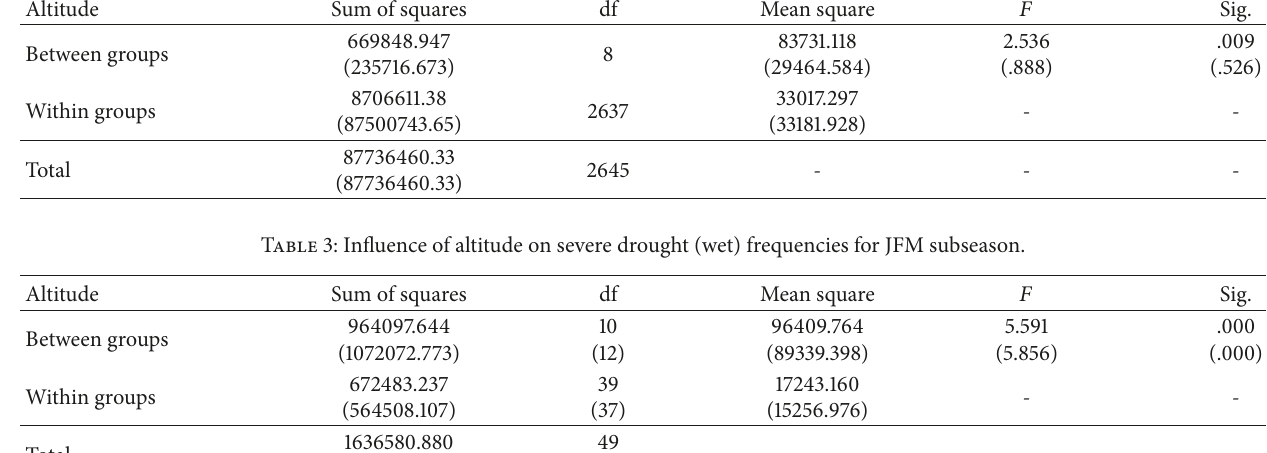
Table 2: Influence of altitude on drought severity for OND and JFM subseasons (in brackets). Altitude Sum of squares df Mean square 𝐹 Sig. Between groups Within groups